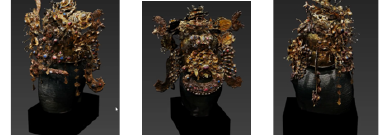
Figure 25-27 . Digital restoration of the Golden Phoenix Crown from the Guizhou Provincial Museum after 3D digital scanning.